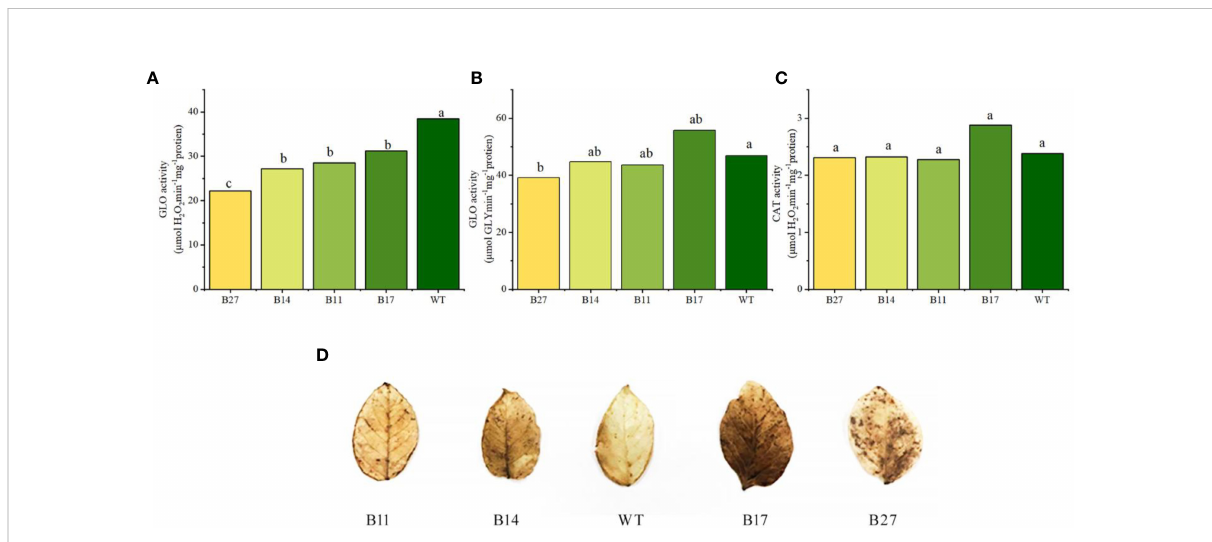
FIGURE 5 Analysis of GLO and CAT enzyme activities in transgenic plants and intravital in situ DAB staining of H 2 O 2 in leaves of transgenic plants. Different letters indicate statistically signi fi cant differences between genotypes as determined by ANOVA using Tukey-Kramer posthoc test (P < 0.05). Data sets without letters indicate no statistical differences. (A) GLO activity measured by POD method. Data are means ± SE of 30 biological replicates. (B) GLO activity measured by phenylhydrazine hydrochloride method. Data are means ± SE of 30 biological replicates. (C) CAT activity. Data are means ± SE of 30 biological replicates. (D) Intravital in situ DAB staining of H 2 O 2 in leaves of transgenic